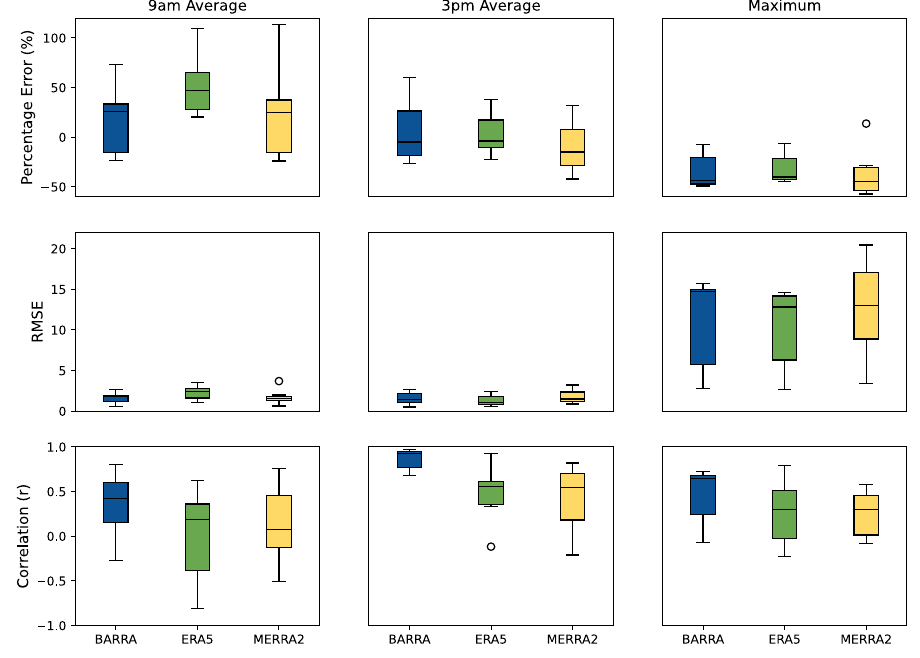
Figure 9. Summary of statistical variance from Bureau of Meteorology weather station data across all locations